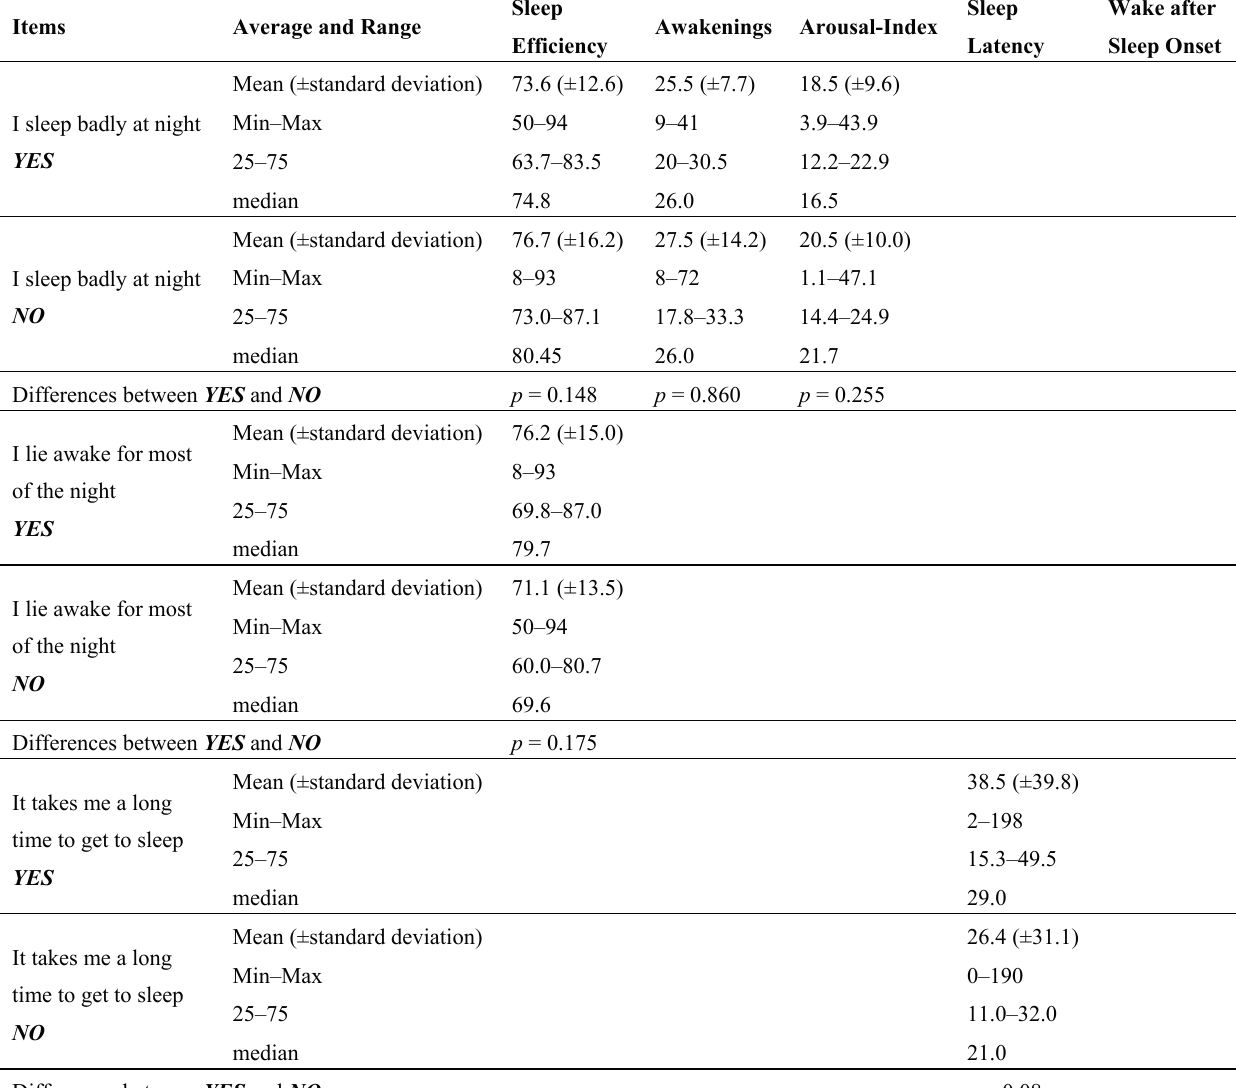
Table 5. Comparison of polysomnographic data and NHP sleep